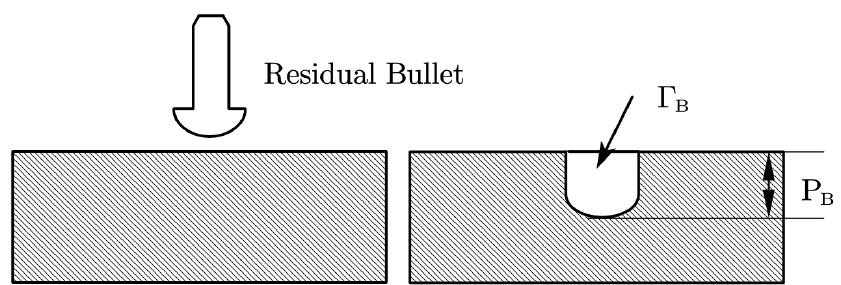
Figure 3. Schematic of obtaining method of experimental result s.